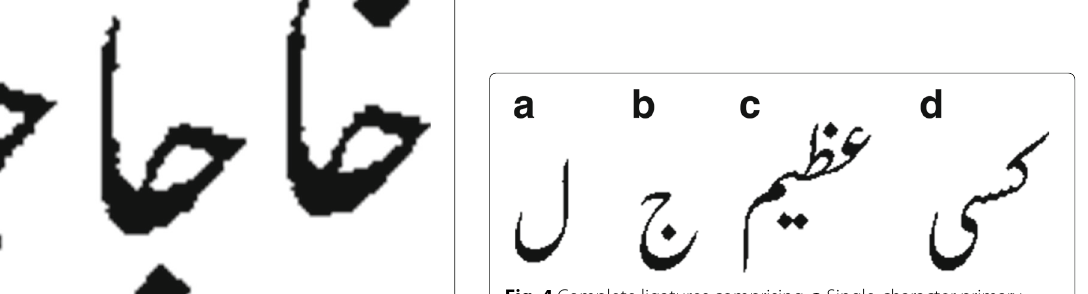
Fig. 3 Complete ligatures with the same primary and different secondary ligatures